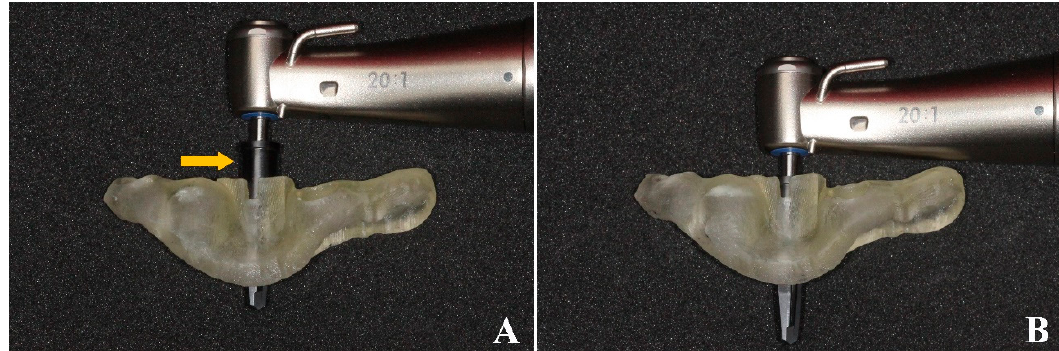
Figure 4. Evaluation of the fabricated surgical guides. ( A ) Surgical guide template with 5.0 mm diameter. ( B ) Surgical guide template with 5.2 mm diameter.